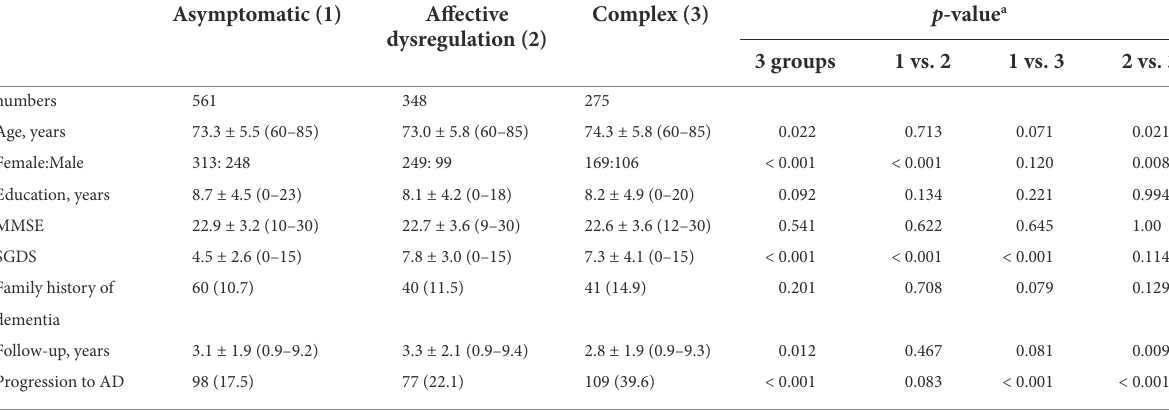
TABLE 3 Demographic and clinical characteristics of the study participants classified based on profiles of mild behavioral impairment domain symptoms.